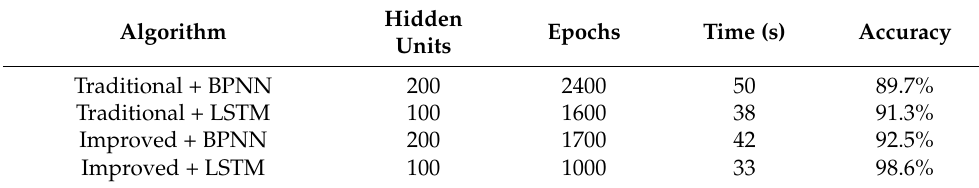
Table 3. Comparison of training effects of different